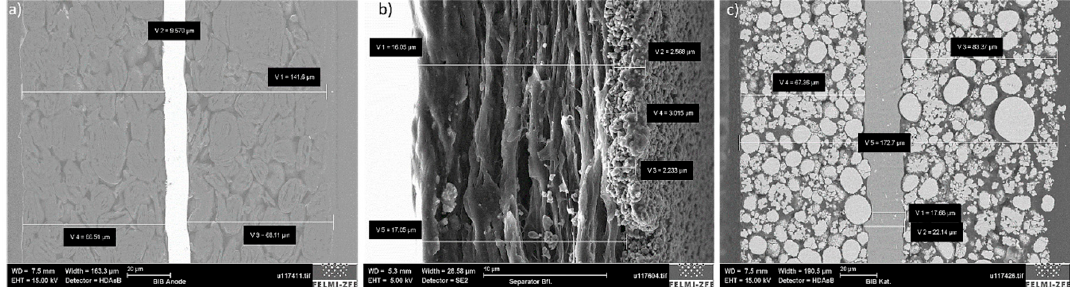
Figure 8. Single-layer analysis in cross-section of the ( a ) anode, ( b ) the separator, and ( c ) the cathode after the broad-ion-beam cutting procedure.